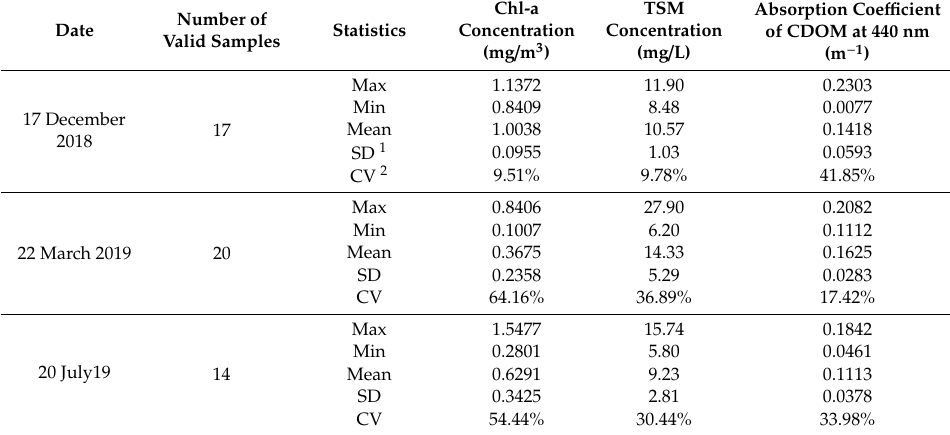
Table 2. Descriptive statistics of the chlorophyll-a (Chl-a) concentrations, total suspended matter (TSM) concentrations, and absorption coe ffi cients of chromophoric dissolved organic matter (CDOM) at water sampling